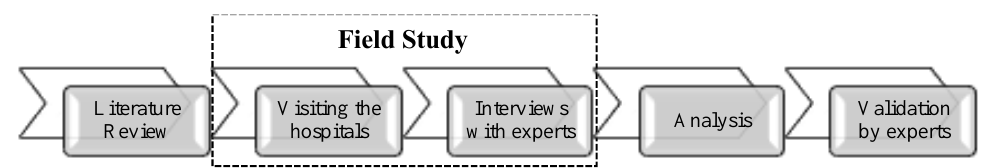
Figure 1. Research methodology.